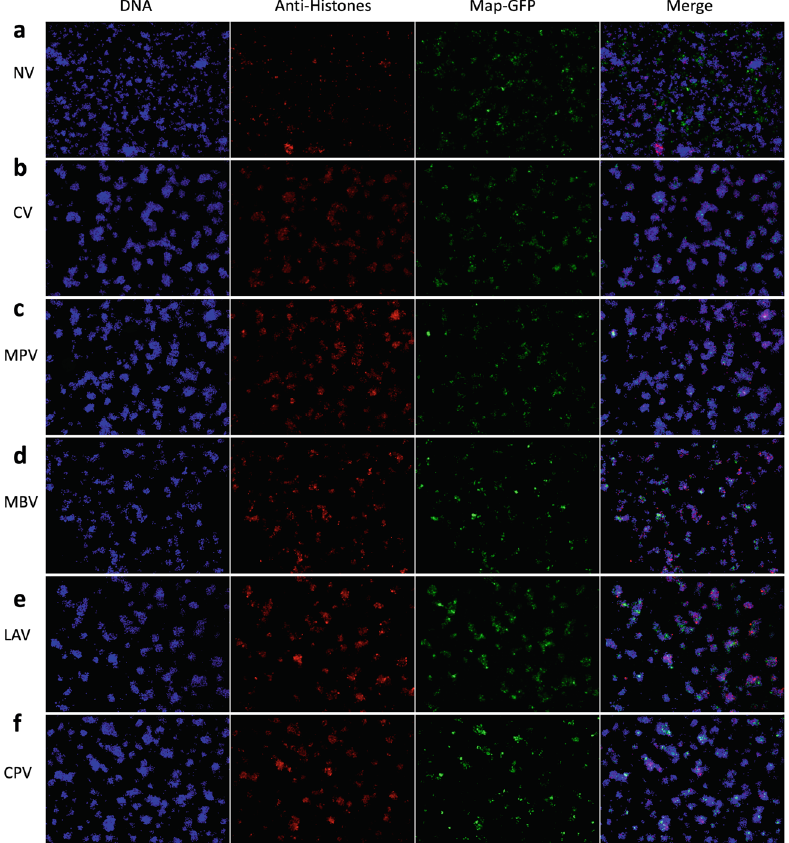
Fig. 4 Micrographs of PMNs in contact with Map. a NV, b CV, c MPV, d MBV, e LAV, and f CPV at PV1 after 4 h incubation with Map-GFP (×10). DAPI (blue), anti-histone (red), and Map-GFP